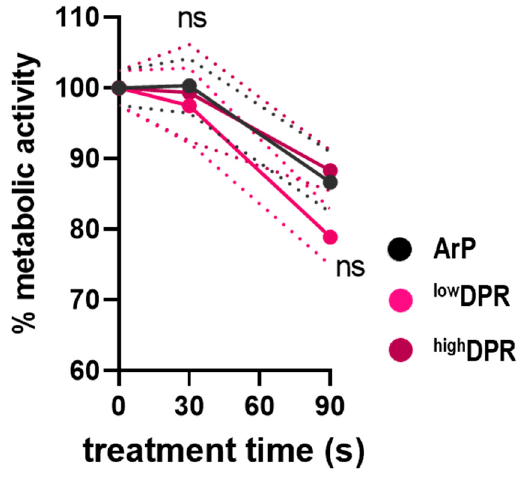
Figure A1. Metabolic activity after gas plasma treatment. Metabolic activity of CT26-luc murine colon carcinoma cells 24 h after exposure to argon plasma (ArP) and additional flow-shaping adapters. Statistical analysis was performed using one-way analysis of variance (ANOVA). ns = non-significant. low DPR = low dynamic pressure reduction; high DPR = high dynamic pressure reduction.